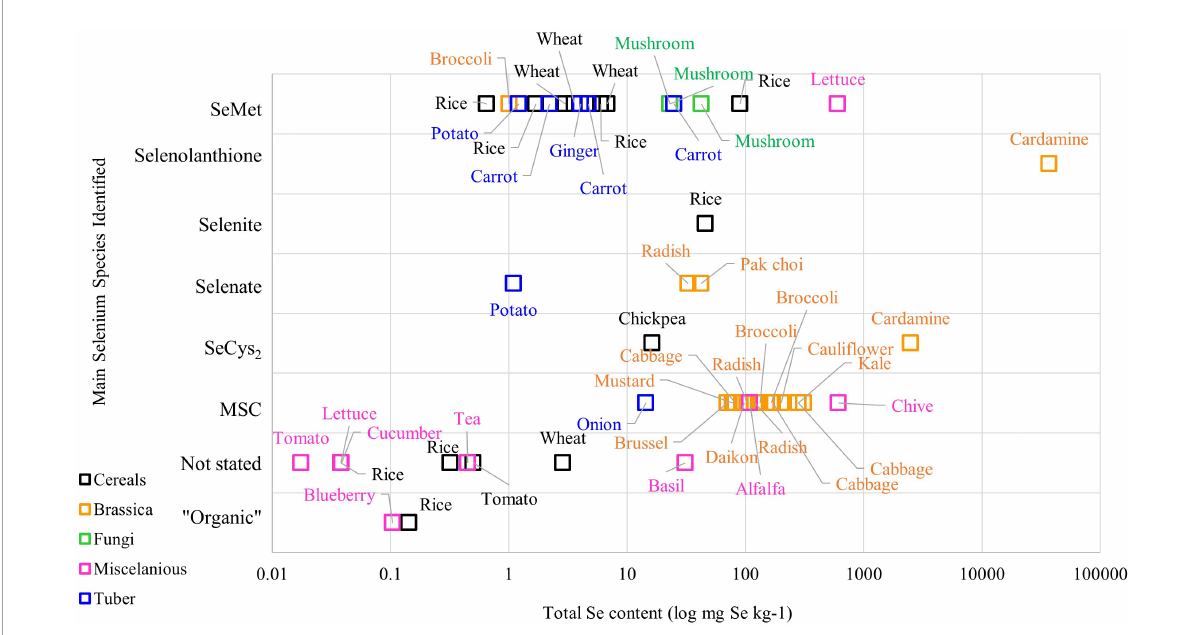
FIGURE1 The Se content and chemical species in plant-based foods from the literature (Please refer to Supplementary Table 1 for the original data from the literature).